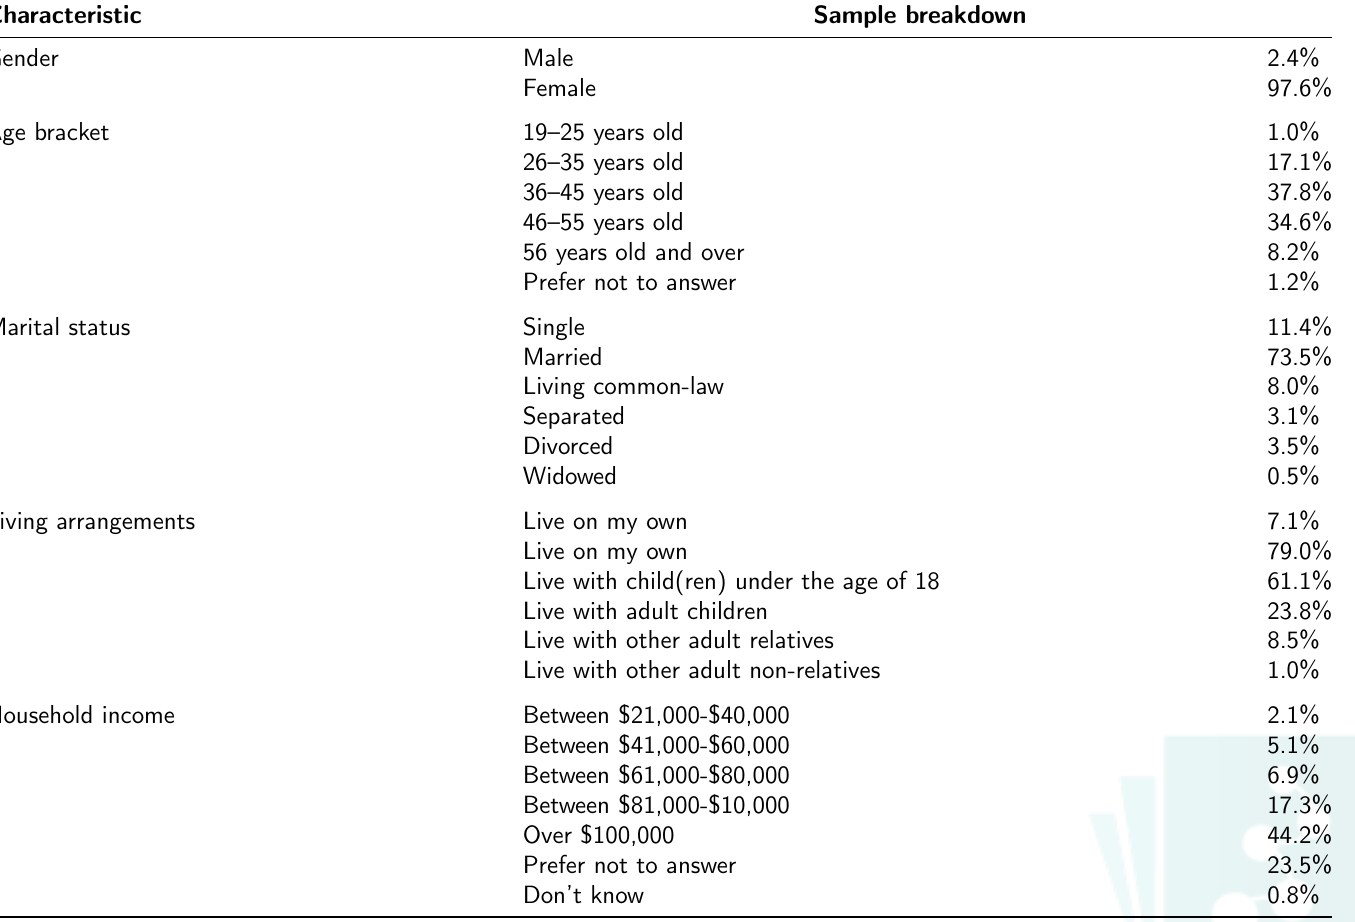
Table 4: Sociodemographic characteristics of the study